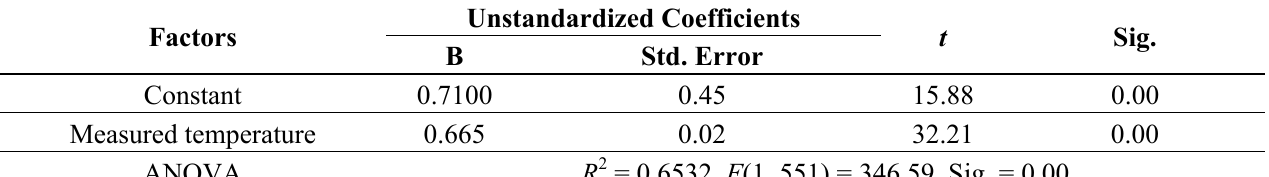
Table 1. ANOVA test result for linear regression